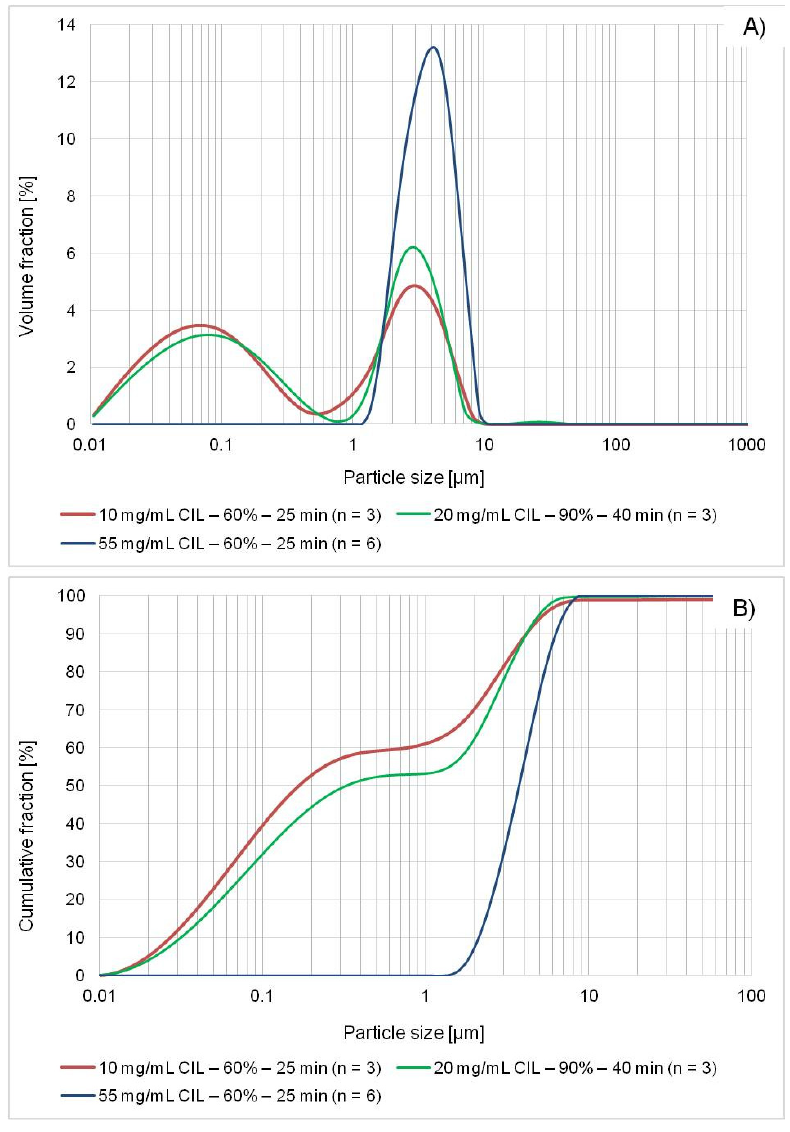
Figure 5. A comparison of monomodal microparticle population and bimodal nano- and microparticles obtained at different independent variable settings of LASP+sonication studied according to central composite design (( A ) frequency size distribution, ( B ) cumulative distribution).